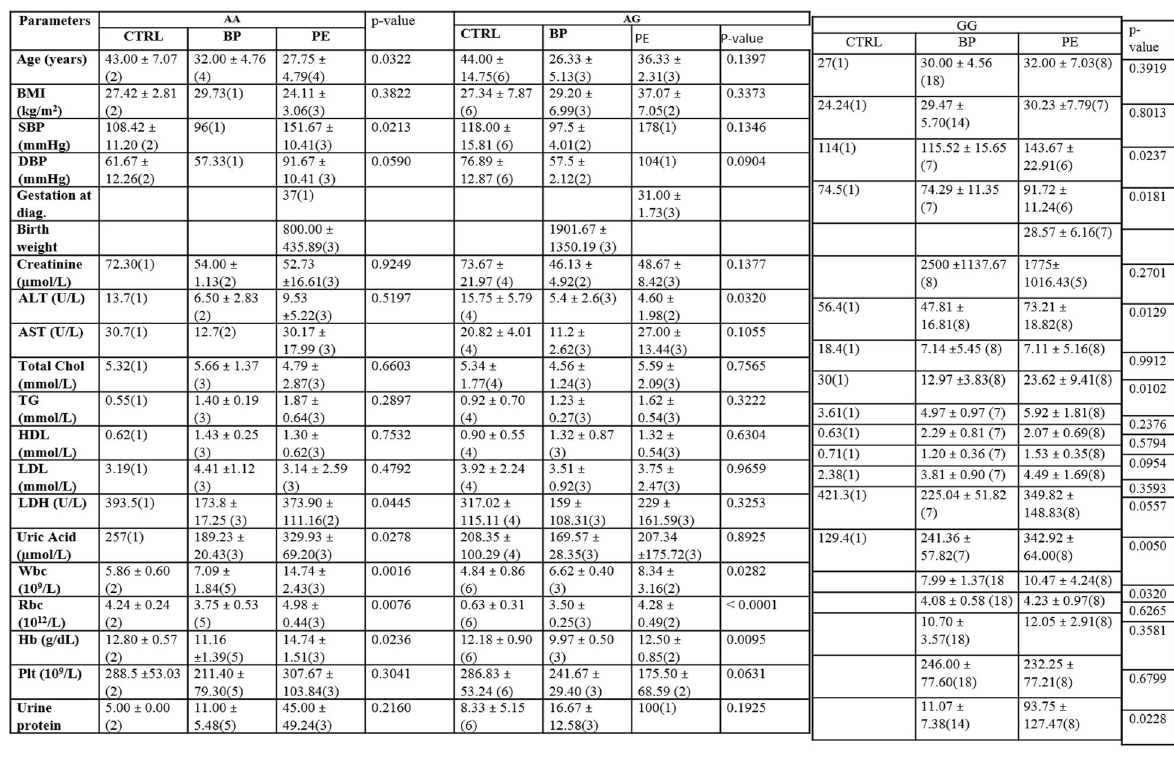
Table 2 depicted three [3] genotypes stratified with clinical variables. Missing values in Ctrl was as expected since these women were apparently healthy and not pregnant. Missing data in other groups were those who were critically ill. Ctrl non-pregnant normotensive, BP pregnant normotensive, PE